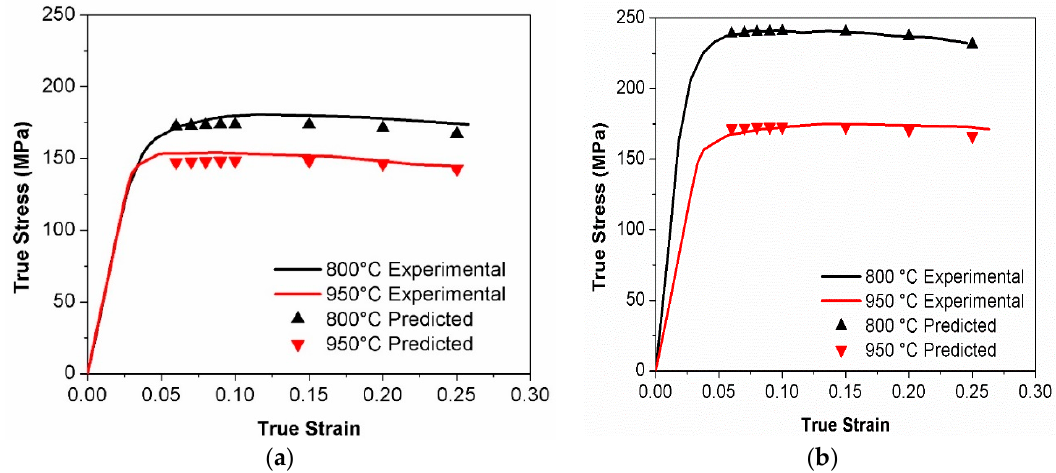
Figure 9. Comparison between experimental and predicted values by the modified Johnson–Cook model at two temperatures (800 and 950 ◦ C); and constant strain rates of ( a ) 0.083 and ( b ) 0.83 s − 1 . The correlation coe ffi cient (R) and mean absolute relative error (MARE) were used to provide information on the accuracy and e ff ectiveness of the linear relationship between experimental and predicted values and measuring the predictability of a numerical model, respectively, as it is shown on Figure 10. The correlation coe ffi cient was 0.9962 and the corresponding mean absolute relative error was 1.43%. Finally, it is important to point out that this model can only be used e ff ectively for the simulation of the mechanical behavior of medium-Mn steel with 0.1 wt.% Nb in the range of the strain rate and deformation temperature conditions under which it was established